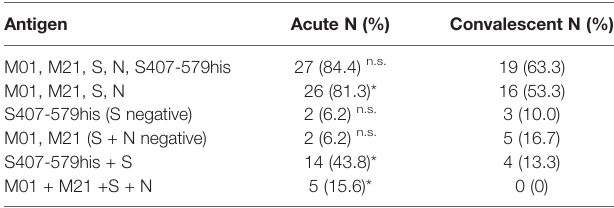
TABLE 3 | IgG antibody response against combined SARS-CoV-2 antigens. Antigen Acute N (%) Convalescent N (%) M01, M21, S, N,